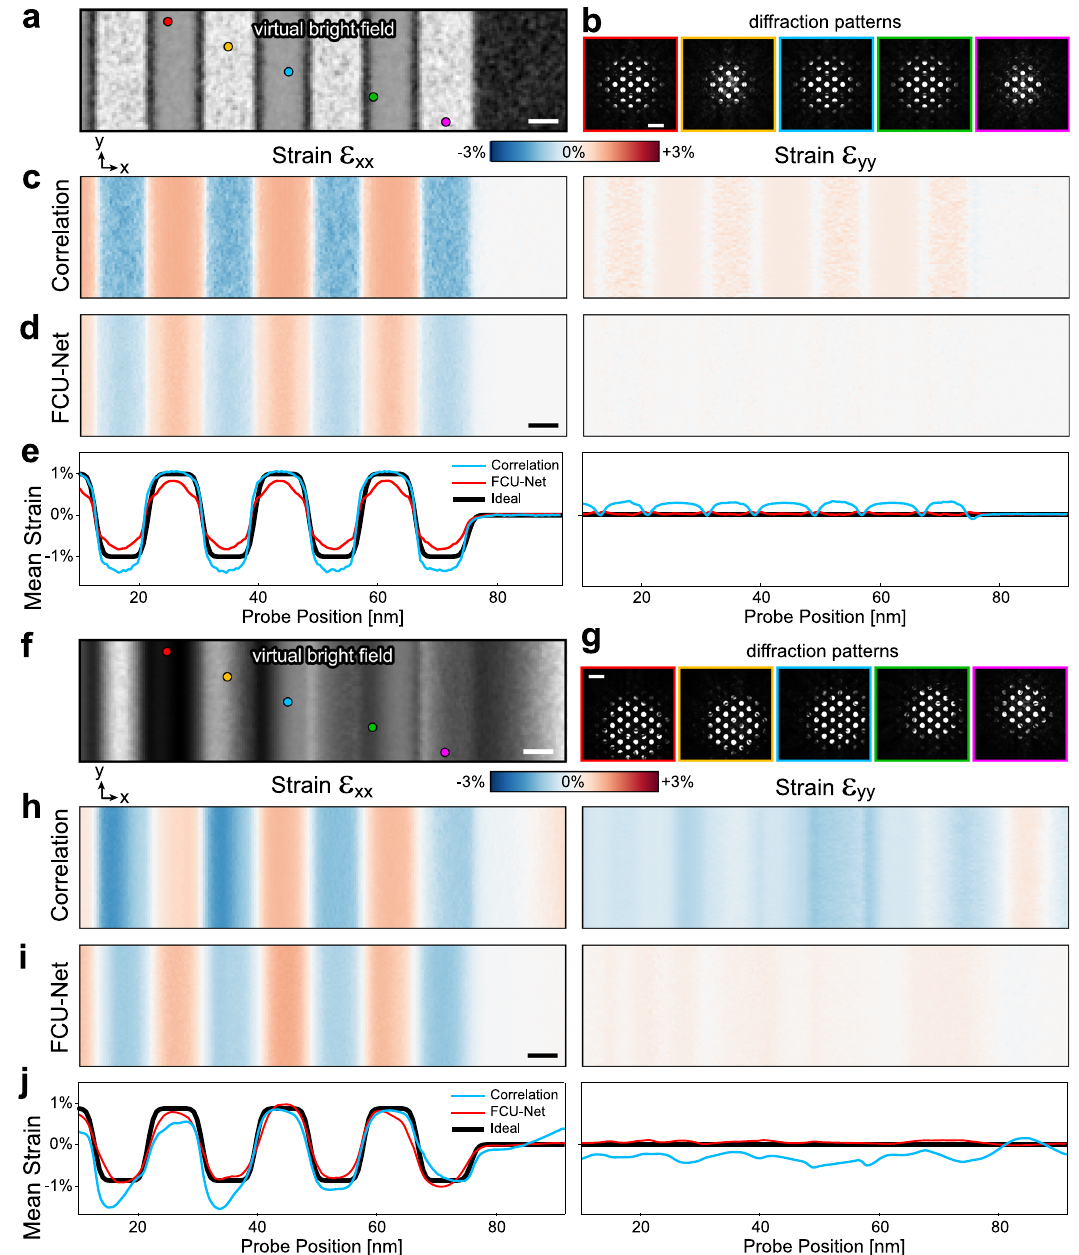
Fig. 4 Strain measurements from diffraction simulations of a Si-Si 0.5 Ge 0.5 multilayer stack. Measurements perform on a crystal a – e without mistilt, and f – j with helical mistilt. a , f Virtual bright fi eld images calculated from the center disk, with the diffraction patterns corresponding to marked probe positions given in b , g . Real space and reciprocal space scale bars are equal to 5 nm and 0.5 Å − 1 , respectively. Strain maps measured with c , h cross-correlation and d , i FCU-Net. e , j Line pro fi les of the mean strain perpendicular (left) and parallel (right) to the